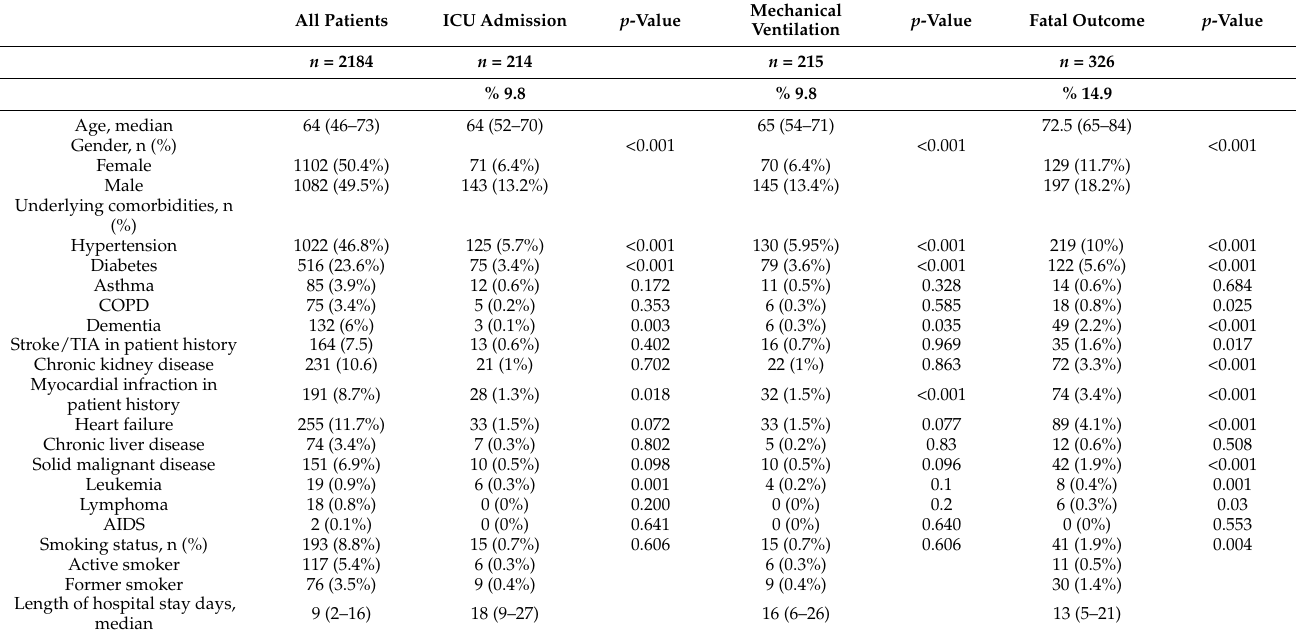
Table 1. Baseline demographic data and comorbidities of 2184 patients hospitalized due to COVID-19. All